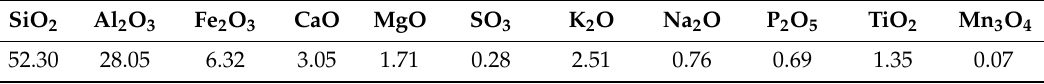
Table 1. X-ray fluorescence (XRF) analysis of fly ash (FA), data supplied by the